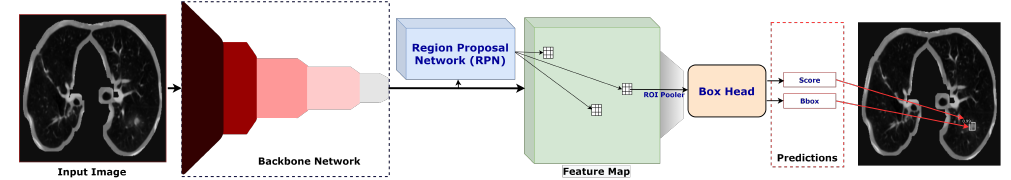
Figure 2. The detailed architecture of Optimized Faster